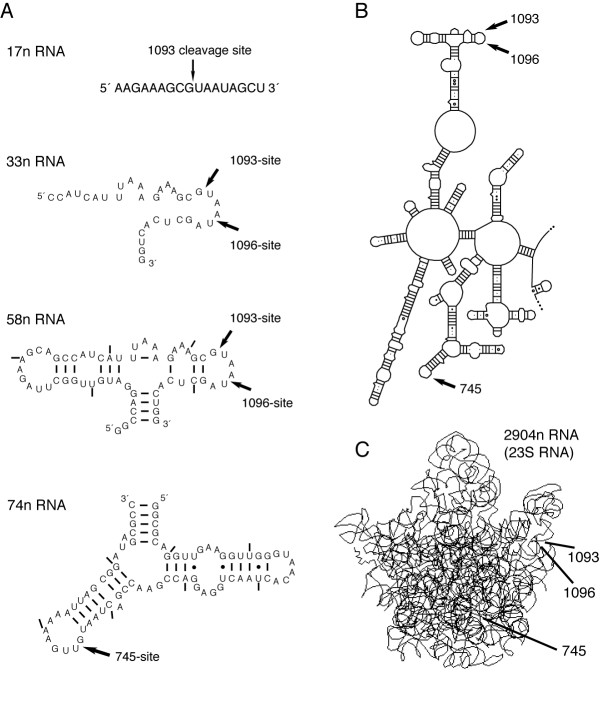
RNA substrates for LNA- and DNAzyme cleavage. (A) 17n minimal RNA substrate; a 33n RNA with metastable secondary structure; and 58n and 74n RNAs that fold into well-defined secondary structures. Cleavage sites for the nucleic acid enzymes at nucleotides 745, 1093 and 1096 are shown by the arrows. The stem-loop secondary structures containing the cleavage targets have been verified by numerous techniques including biochemical probing [28], NMR [29] and crystallography [30-32]. (B) Secondary structure of domain II of 23S RNA (2904n RNA), which contains all three cleavage sites. (C) Higher-order folding of the rRNA (2904n) within the 50S ribosomal subunit; all the stem-loops in the smaller RNAs used here are maintained in the 2904n RNA (refs, PDB 1JJ2, [33]).